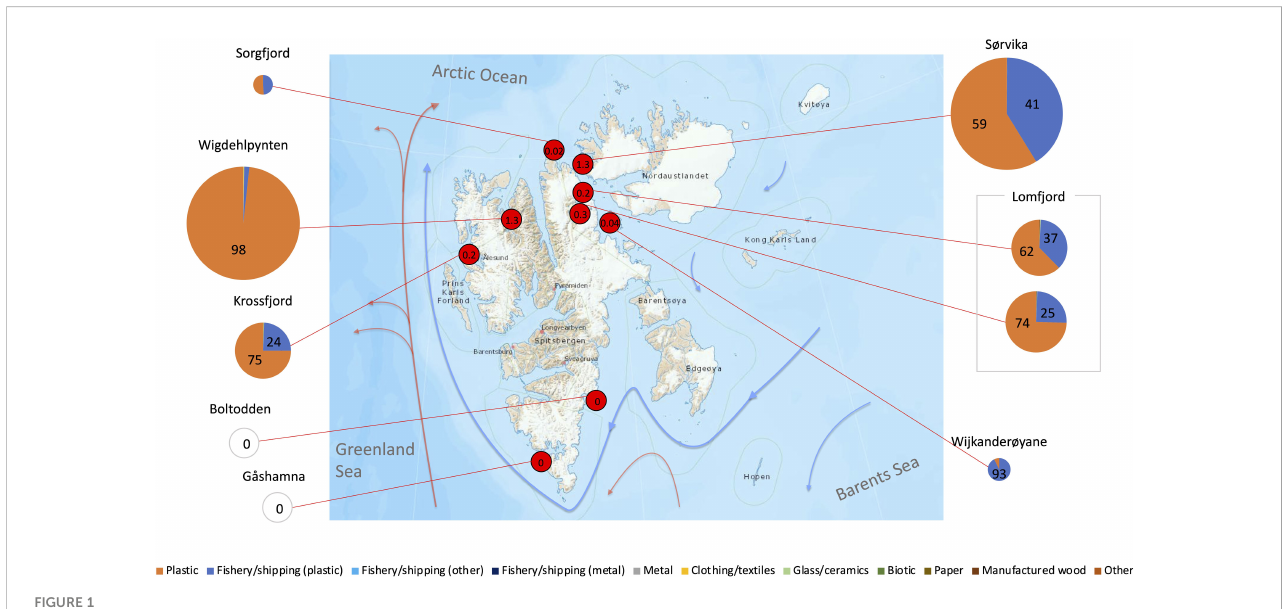
FIGURE 1 Map of all locations of beach debris surveys (abundance) depicted by red dots with number of items collected m -2 , which is also scaled by the relative size of pie charts showing the rounded proportions [%] of debris categories. Log (x+1)-transformed abundances were used to improve the graphic representation. Arrows depicting the warm West Spitsbergen Current (red) and cold East Spitsbergen Current (blue) were placed according to Svendsen et al. (2002) (Map © Norwegian Polar